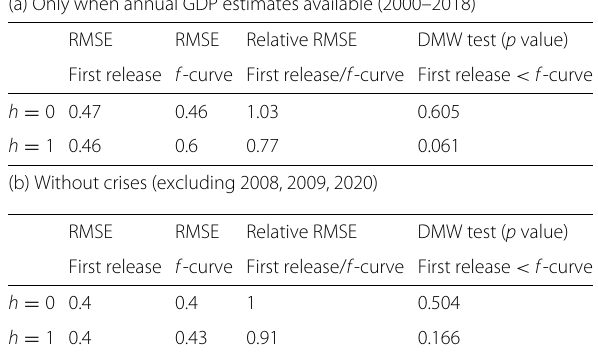
Table 2 Subsample evaluation for real GDP growth: First release vs. f -curve. Root-mean-squared errors (RMSE) for forecasts on days with a new quarterly GDP release. A lower RMSE implies higher predictive accuracy. h = 0 ( h = 1) denotes the forecast for the current (next) quarter. Panel (a) shows the evaluation for GDP figures that include the annual SFSO estimates (until 2018). Panel (b) excludes economic crises. As benchmark, we use the first quarterly release of the corresponding quarter. The Diebold-Mariano-West (DMW) test provides a p value for the null hypothesis of equal predictive accuracy against the alternative written in the column header (Diebold and Mariano 2002; West 1996). We assume a quadratic loss function (a) Only when annual GDP estimates available (2000–2018) RMSE RMSE Relative RMSE DMW test ( p value) First release f -curve First release/ f -curve First release < f -curve h = 0 0.47